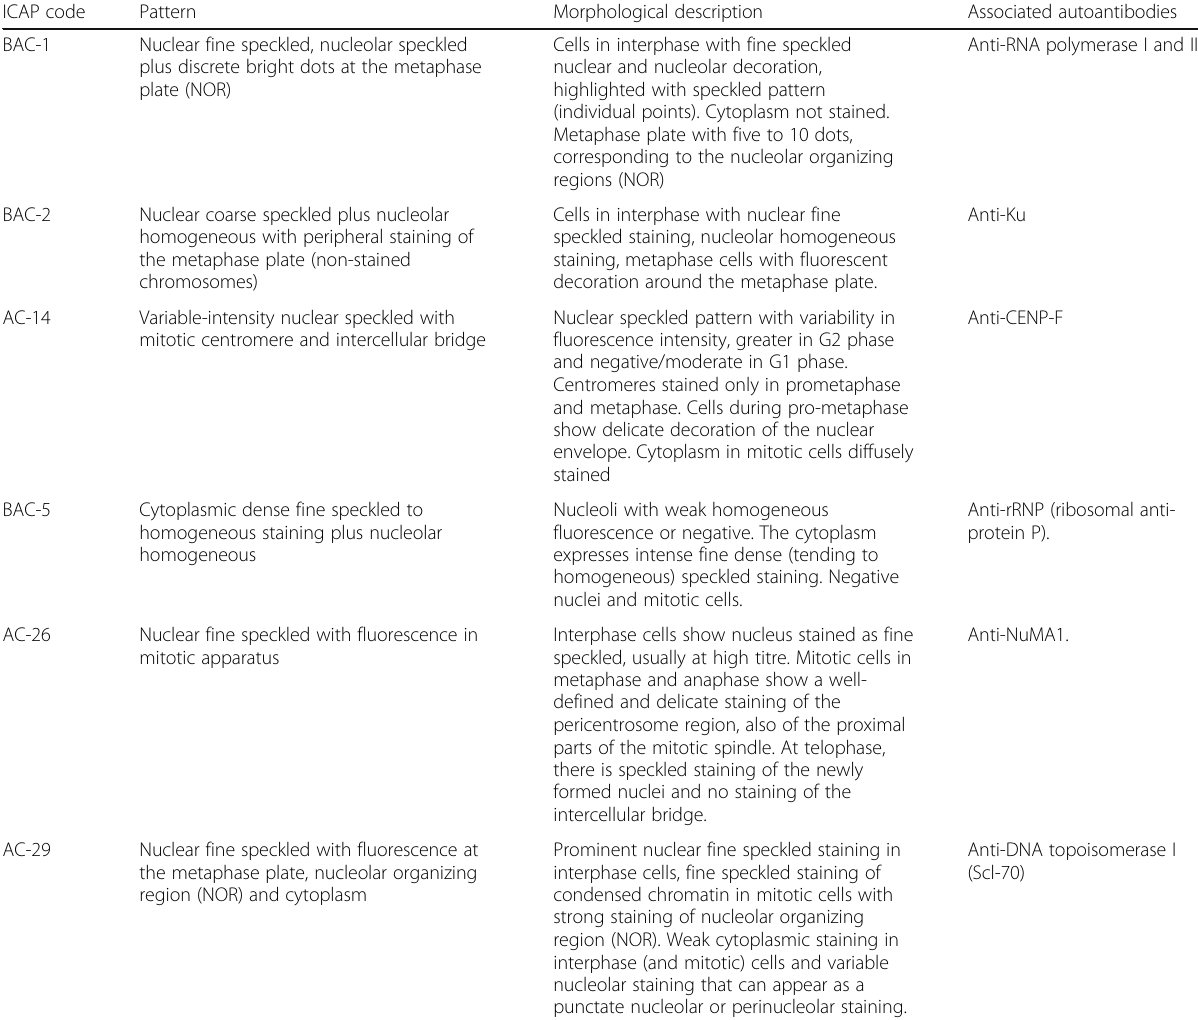
Table 2 Compound/mixed patterns of the Brazilian consensus for autoantibodies on HEp-2 cells ICAP